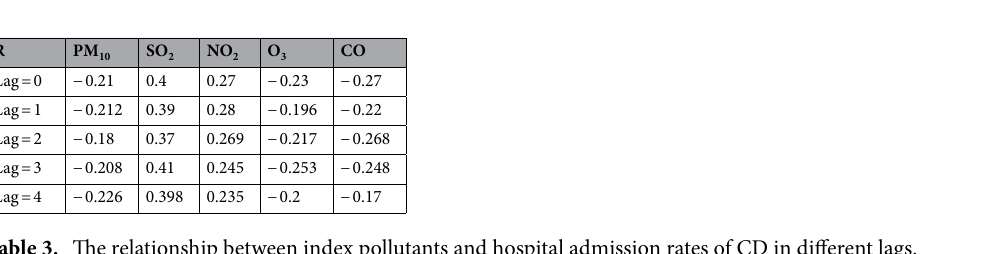
Table 3. The relationship between index pollutants and hospital admission rates of CD in different